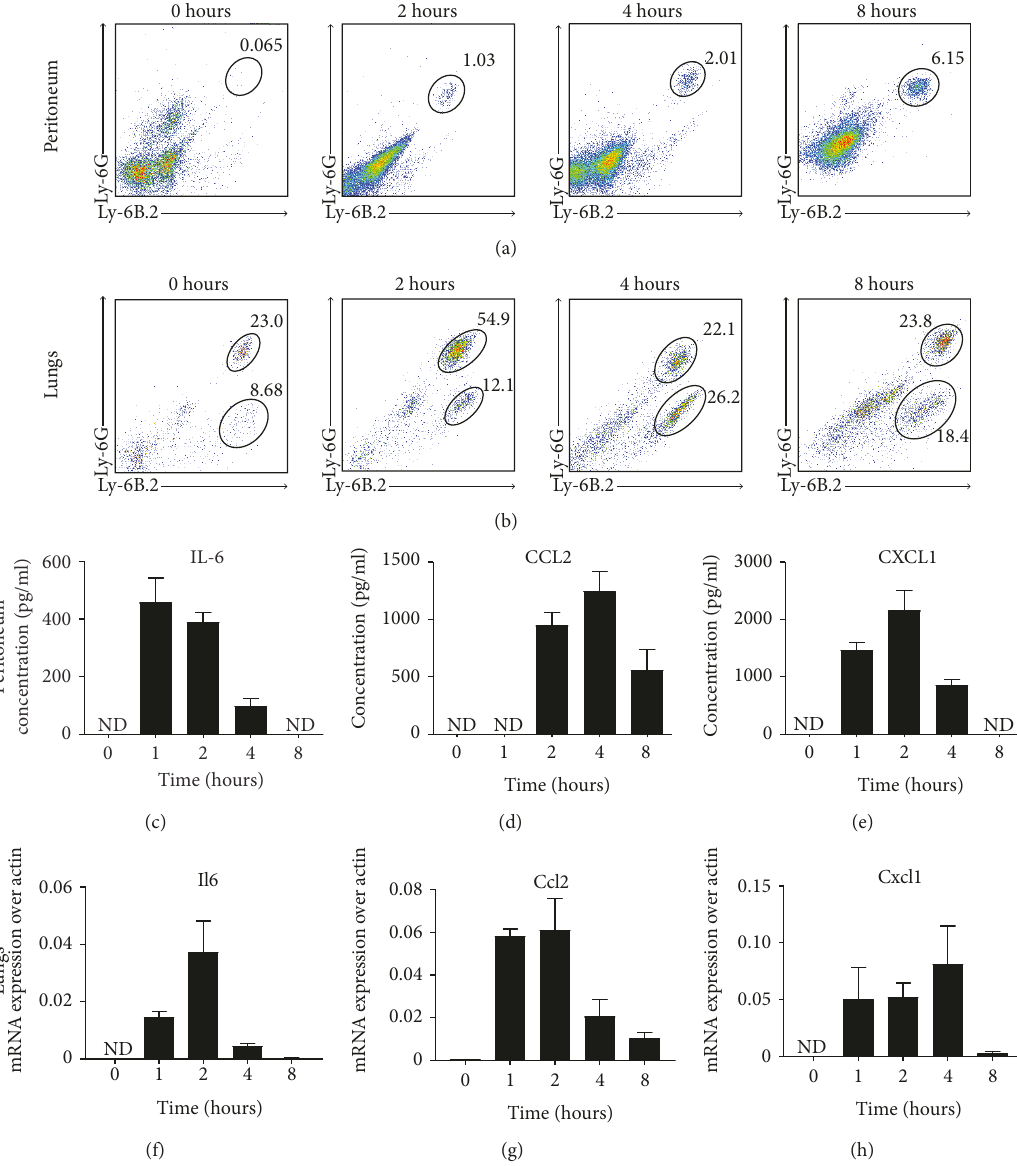
Figure 1: Immune cell recruitment to peripheral tissues is maximal at 2 hours post LPS challenge. Male C57BL/6J mice (8 – 10 weeks old) were administered i.p. with 1mg/kg LPS and innate immune cell recruitment to peripheral tissues, and production of proin fl ammatory mediators was followed for 8 hours. Naïve animals were used for the steady state measurements. Peritoneal lavage fl uid (a) and lungs (b) were harvested to assess the presence of neutrophils (CD45 + Ly-6G hi Ly-6B.2 + ) and monocytes (CD45 + Ly-6G mid Ly-6B.2 + ) by fl ow cytometry. Representative dot plot graphs gated on CD45 + cells are shown for the peritoneum (a) and lungs (b). The levels of the cytokine IL-6 (c) and chemokines CCL2 (d) and CXCL1 (e) were measured in peritoneal fl uid by ELISA. The mRNA levels of Il6 (f), Ccl2 (g), and Cxcl1 (h) in lung homogenates were measured by qRT-PCR. Data are from one experiment with 5-6 mice per time point. Mean+SEM are represented in all bar graphs. ND: not